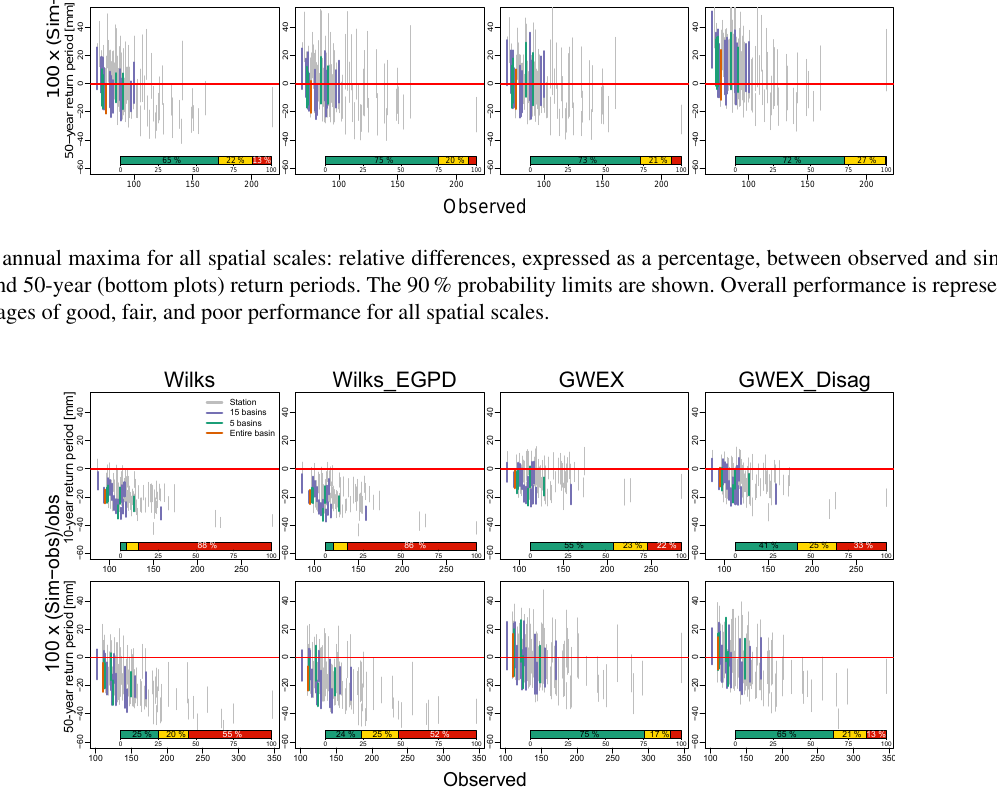
Figure 13. The 3-day annual maxima for all spatial scales: relative differences, expressed as a percentage, between observed and simulated 10-year (top plots) and 50-year (bottom plots) return periods. The 90% probability limits are shown. Overall performance is represented by the indicated percentages of good, fair, and poor performance for all spatial